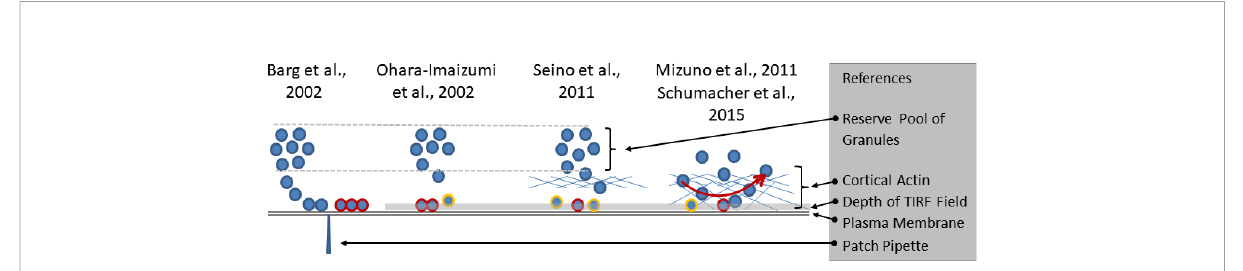
FIGURE 1 Growing complexity of the relation between granule mobility and fusion competence. The electrophysiological investigations (left part of the sketch) led to the de fi nition of a readily releasable pool of docked and primed granules (highlighted by red rims), the emptying of which caused the nadir between the fi rst and the second phase of insulin secretion. The slow re fi lling from a distant reserve pool was considered as the cause of the slower pace of secretion during the second phase. The initial TIRF studies (second from left) considered the predocked granules as the correlate of the readily releasable pool and noted an increasingly relevant contribution of newcomer granules (highlighted by yellow rims) with time. Later (second from right), a predominant contribution of restless newcomer granules to the fi rst phase was described. The lower fusion rates during prolonged stimulation were ascribed to the passage through the cortical actin layer. The rightmost part of the sketch combines two sets of observations. The cortical actin layer, which extends to the immediate vicinity of the plasma membrane is not just an obstacle, but a near-membrane storage site of granules. There is a constant exchange of granules which arrive at the submembrane space and leave again after different periods of residence, mostly within one second. Fusion is possible after varying periods of residence.